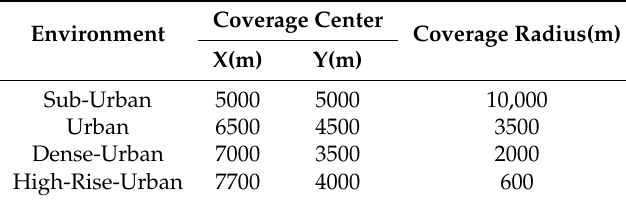
Table 1. Covering areas of the environments.